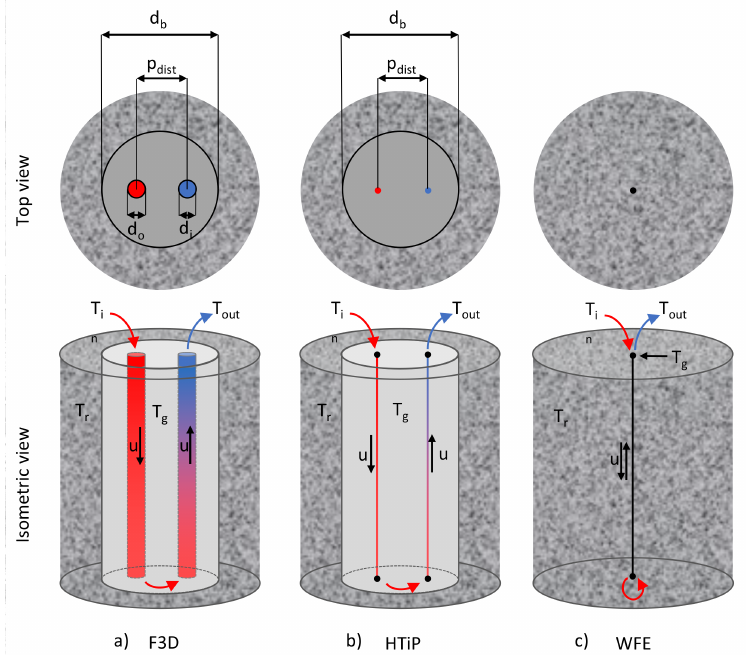
Figure 1. Conceptual drawing of three approaches for the modelling of a borehole heat exchanger (BHE): ( a ) full 3D (F3D) by Oberdorfer et al. [17]; ( b ) Heat Transfer in Pipes (HTiP); and ( c ) weak form equations (WFE) by Al-Khoury et al.